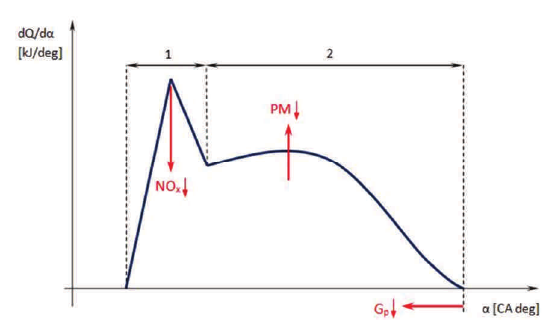
Fig. 12. Schema of the rate of heat release in a diesel engine: 1 – kinetic combustion phase 2 – diffusion combustion